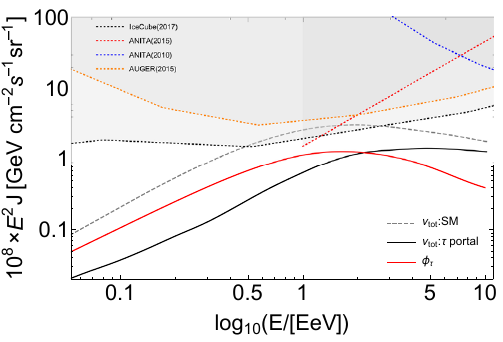
Figure 6. The energy loss length for dark matter (black solid).